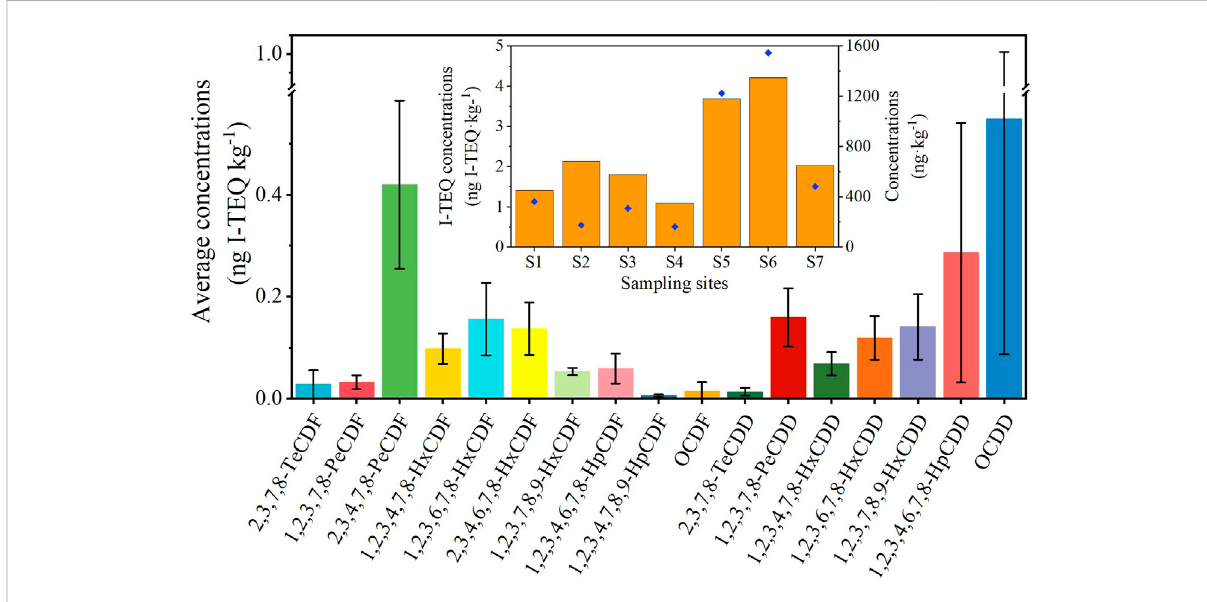
Figure 2 and Table 1. The dioxins concentrations and total I-TEQ values of the studied soil samples vary from 162.20 to 1,544.70 ng kg − 1 and 1.10 – 4.21 ng I-TEQ · kg − 1 , respectively, with